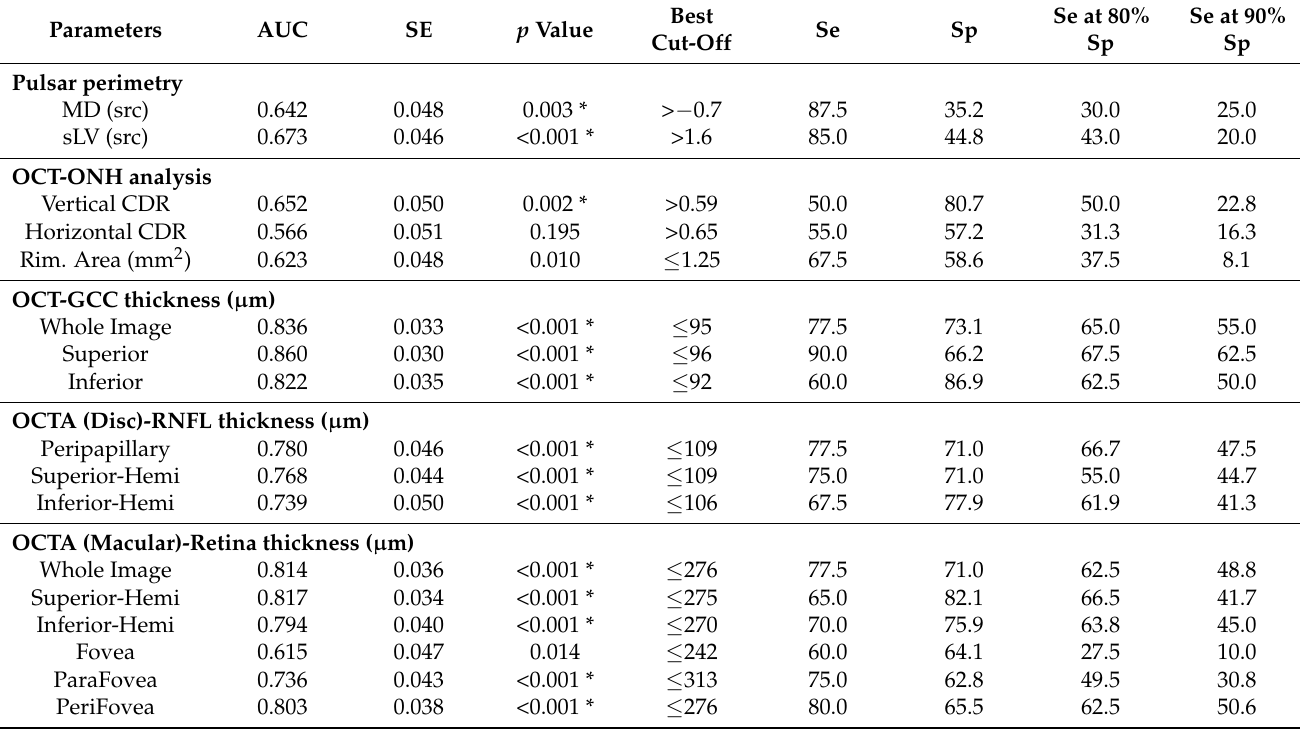
Table 3. Results of receiver operating characteristic analysis between control and pre-perimetric glaucoma